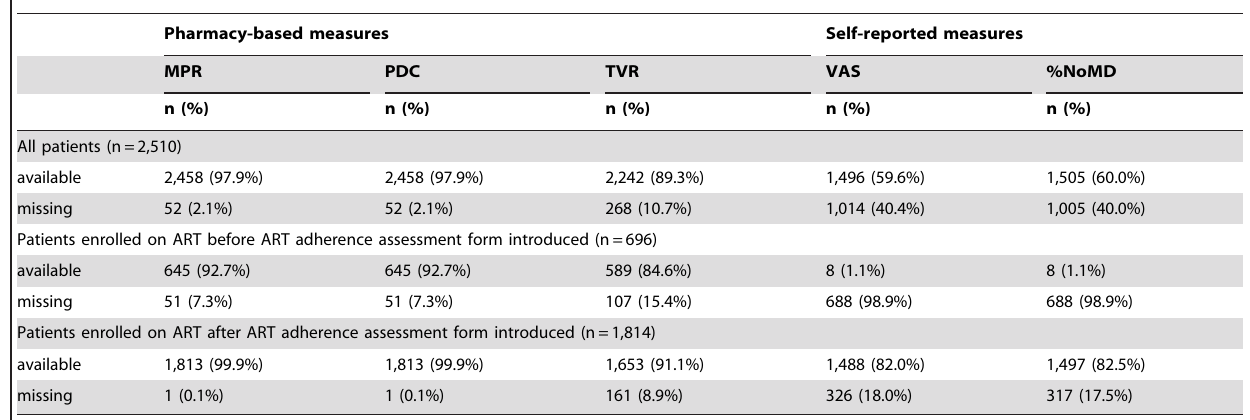
Table 3. Availability of Adherence Measures during First 6 Months on ART.